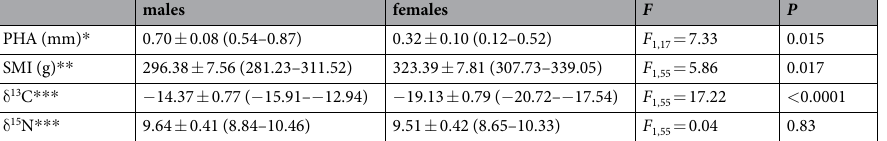
Table 1. Mean values ( ± SE and 95% confident intervals) of PHA-induced response (PHA), body condition (SMI), and carbon ( δ 13 C) and nitrogen ( δ 15 N) stable isotopes in male and female black-tailed godwits staging in Extremadura. See text for sample sizes and statistical details. * Model including body mass 1/3 as covariate